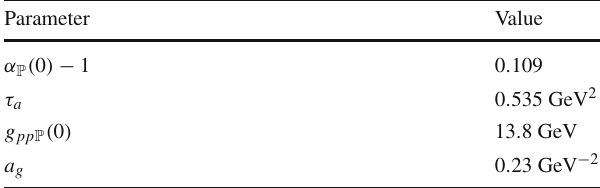
Table 1 Parameters for proton–proton elastic scattering amplitude